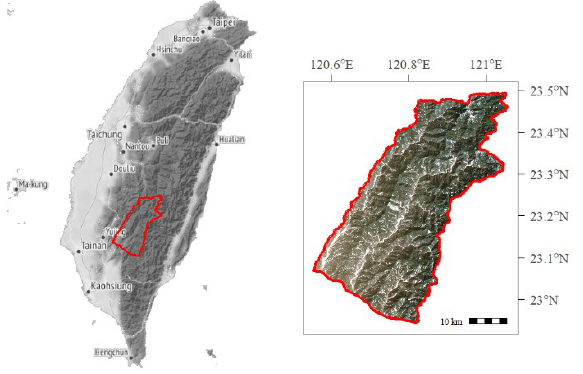
Figure 1. Study area in the south-central part of Taiwan.